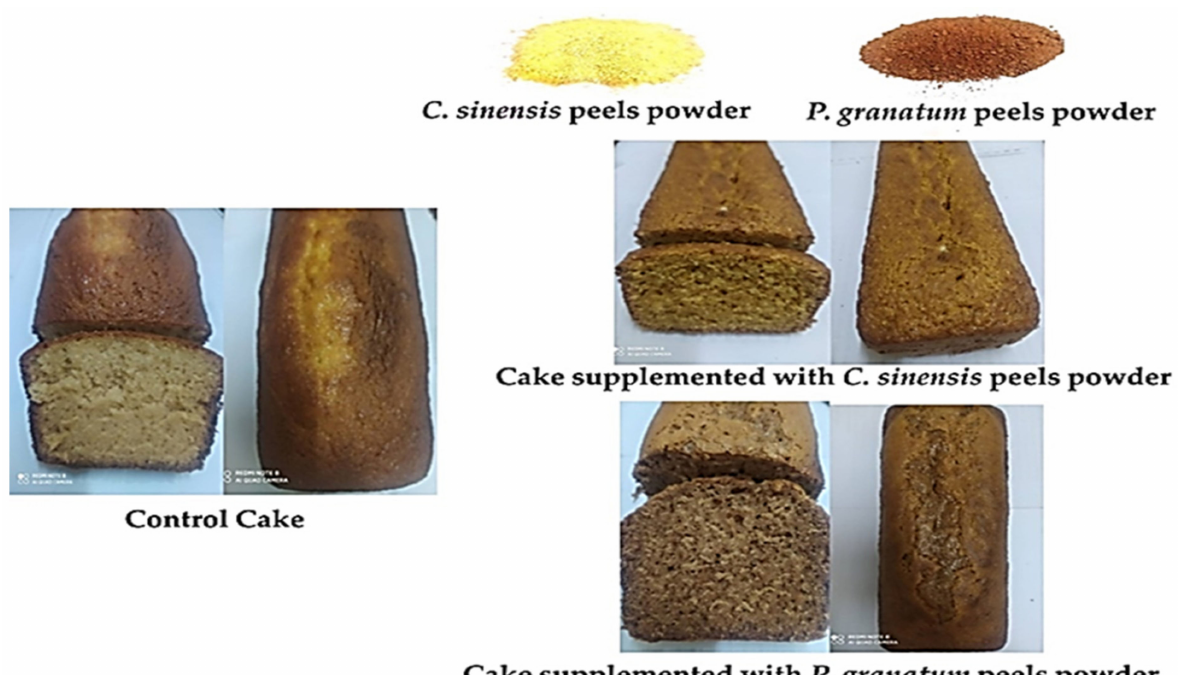
Figure 12. Photograph of cakes after baking (control cake, cake substituted with 3% pomegranate peel powder, and cake substituted with 10% orange peel